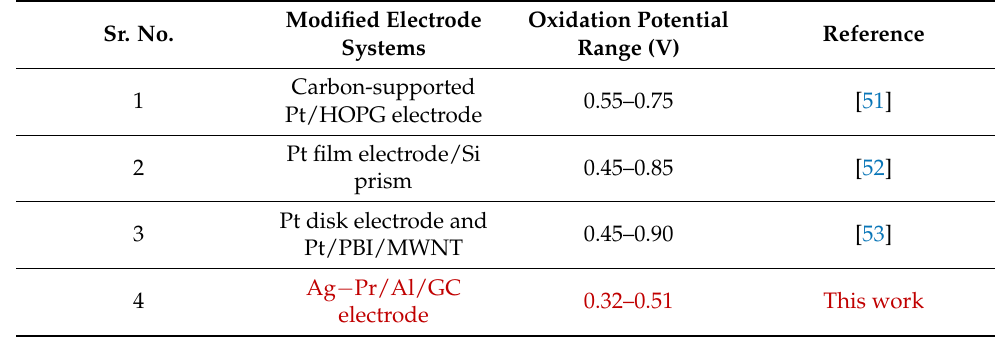
Table 4. Comparison of oxidation potentials for different systems.